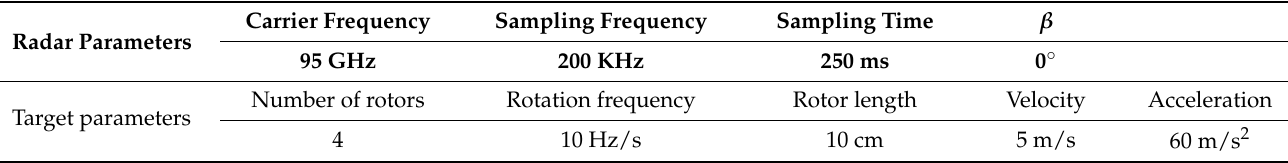
Table 5. Radar and Target Parameters.